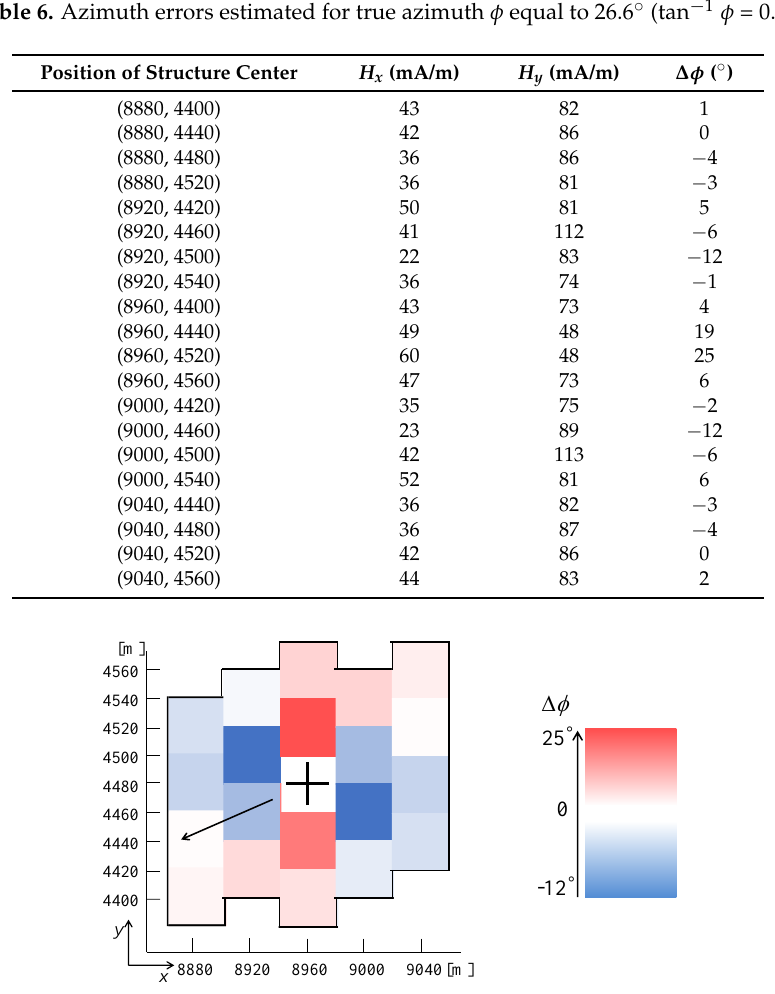
Table 6. Azimuth errors estimated for true azimuth φ equal to 26.6 ˝ (tan ´ 1 φ = 0.5).